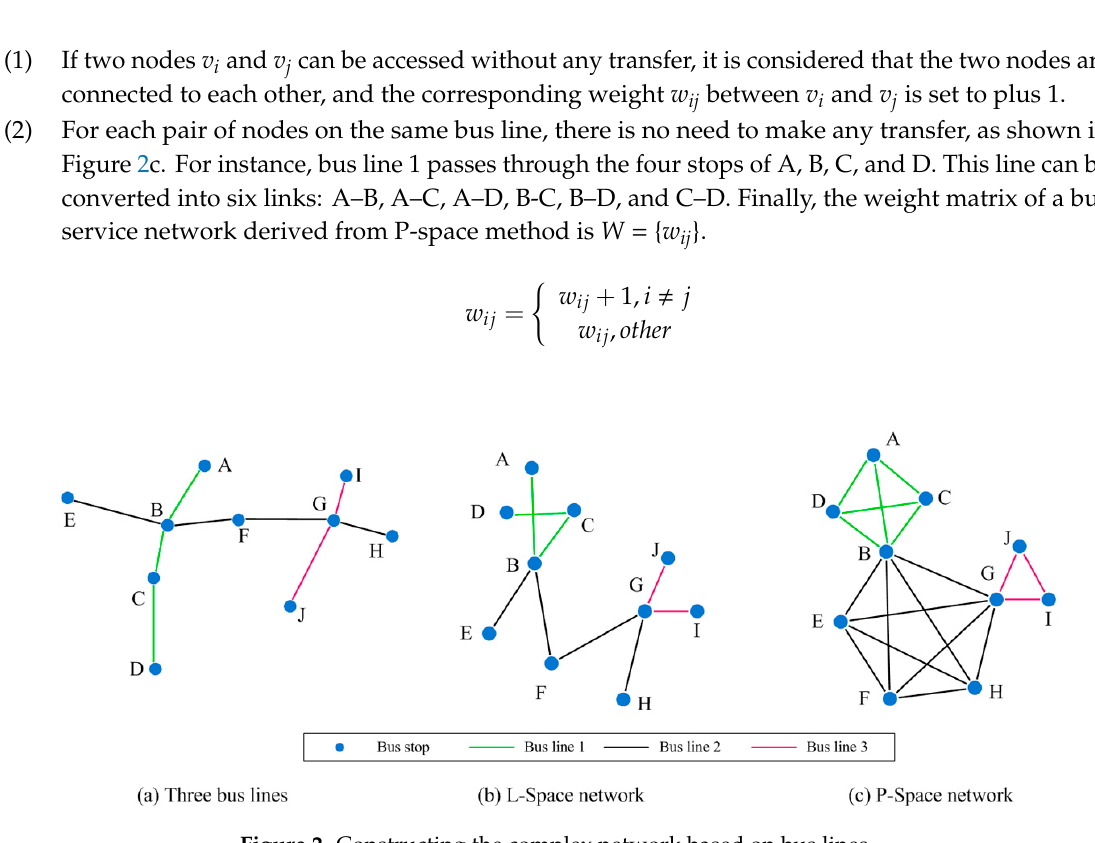
Figure 2. Constructing the complex network based on bus lines.